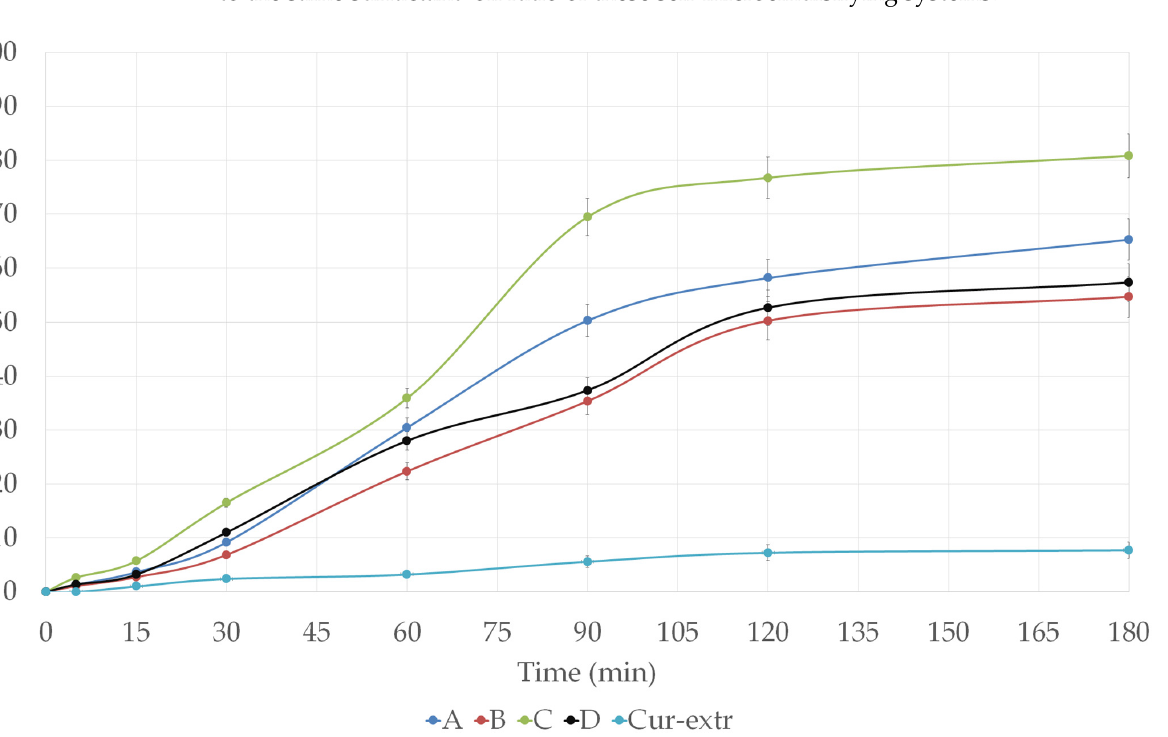
Figure 5. In vitro dissolution profiles of curcumin from the different SNEDDS and SMEDDS compositions and from curcumin extract loaded capsules in simulated intestinal fluid (SIF) without pancreatin (pH 6.8) at 37 °C.